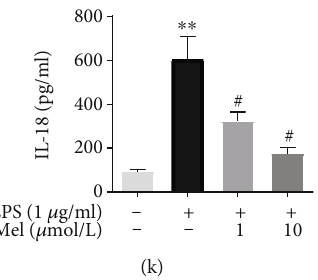
Figure 4: Melatonin reduced cell pyroptosis in LPS-exposed hiPSC-CMs. (a) Representative images of fl ow cytometry results. (b) Quantitative analysis of pyroptosis rate. (c) Representative immunoblots of NLRP3, cleaved casp-1, and GSDMD-NT. (d) Quantitative analysis of NLRP3. (e) Quantitative analysis of cleaved casp-1. (f) Quantitative analysis of GSDMD-NT. (g) Representative immunoblots of cleaved IL-1 β and cleaved IL-18. (h) Quantitative analysis of cleaved IL-1 β . (i) Quantitative analysis of cleaved IL-18. (j) IL-1 β level examined by ELISA assay. (k) IL-18 level examined by ELISA assay. n ≥ 3 ; ∗ P < 0 : 05 vs. control; ∗∗ P < 0 : 01 vs. control; # P < 0 : 05 vs. LPS; ## P < 0 : 01 vs.